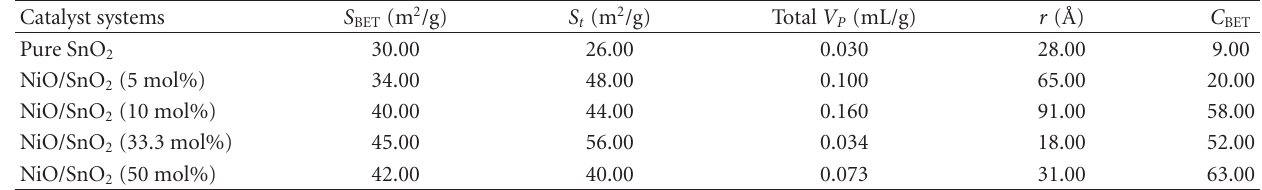
Table 2: Texture parameters of pure and nickel-doped SnO 2 nanoparticles.